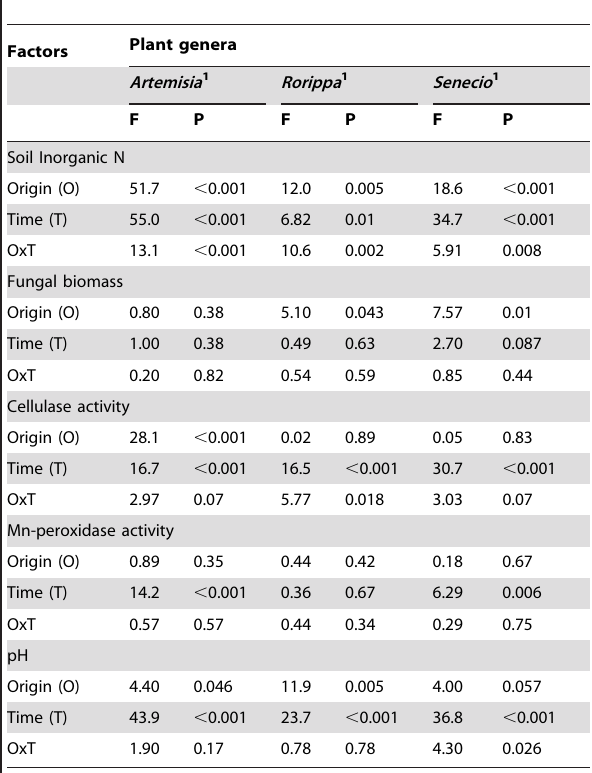
Table 4. ANOVA for effects of litter effects on plant